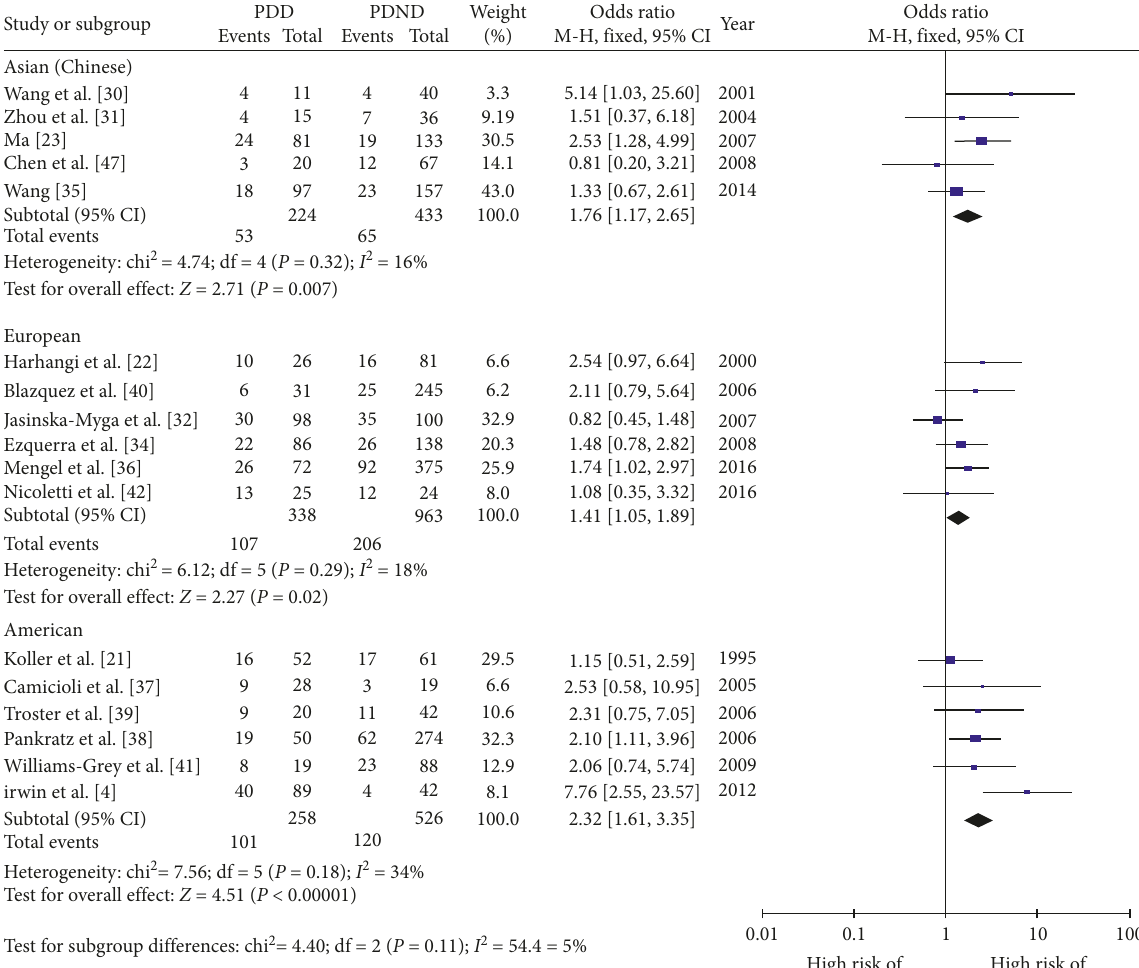
groupTest for subgroup differences: chi 2 = 4.40; df = 2 ( P = 0.11); I 2 = 54.4 = 5% Figure 8: Forest plot for the influence of geographical distribution on Parkinson’s disease dementia onset risk of ε 4+ patients compared with ε 4 patients. −